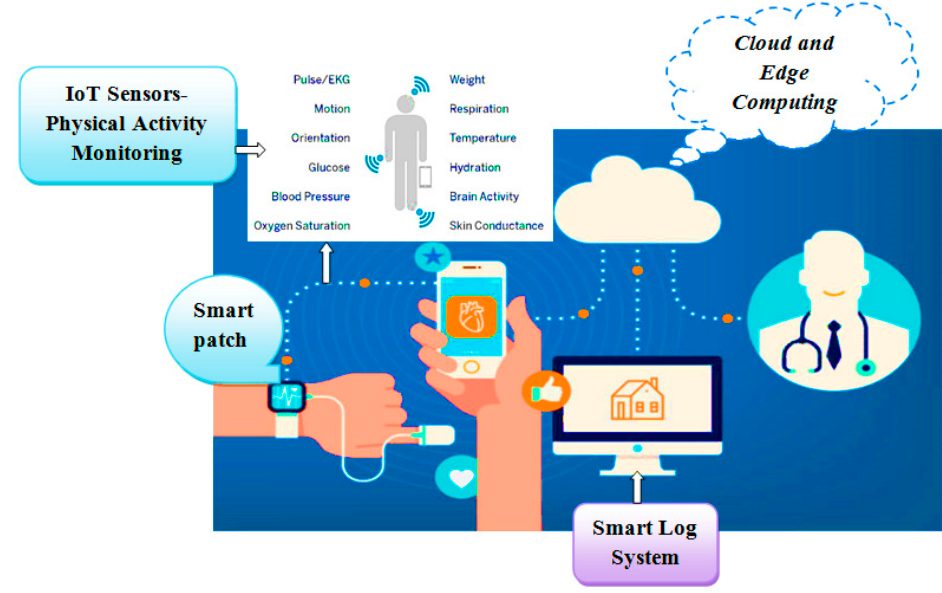
Figure 2. Wearable smart log patch with Internet of Things (IoT) sensor in edge computing environment.